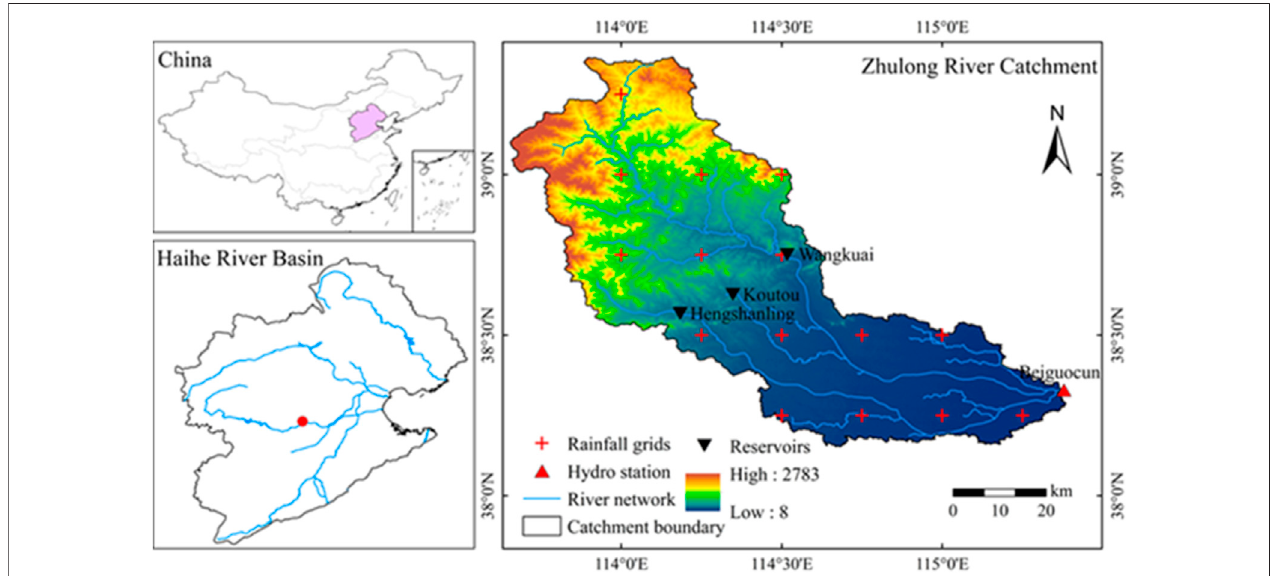
FIGURE 1 | The terrain, drainage and stations distribution of the Zhulong River catchment.